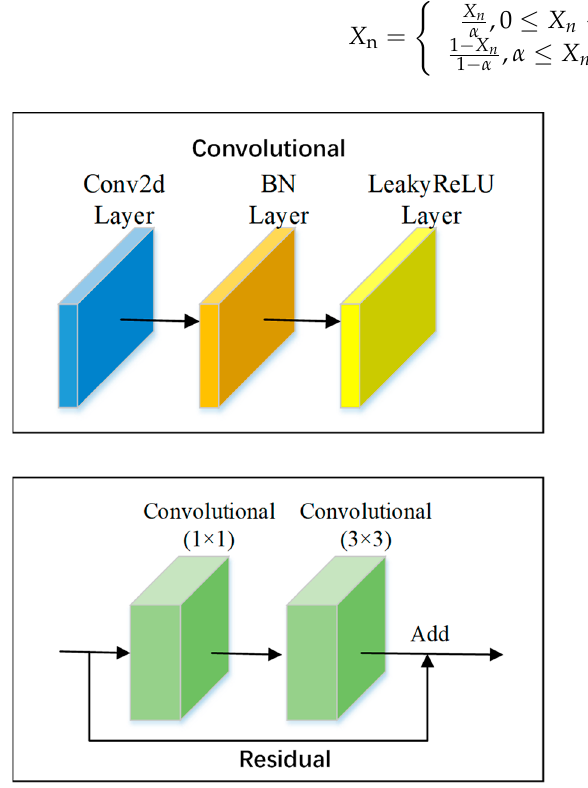
Figure 1. Structure of DarkNet53 network model.